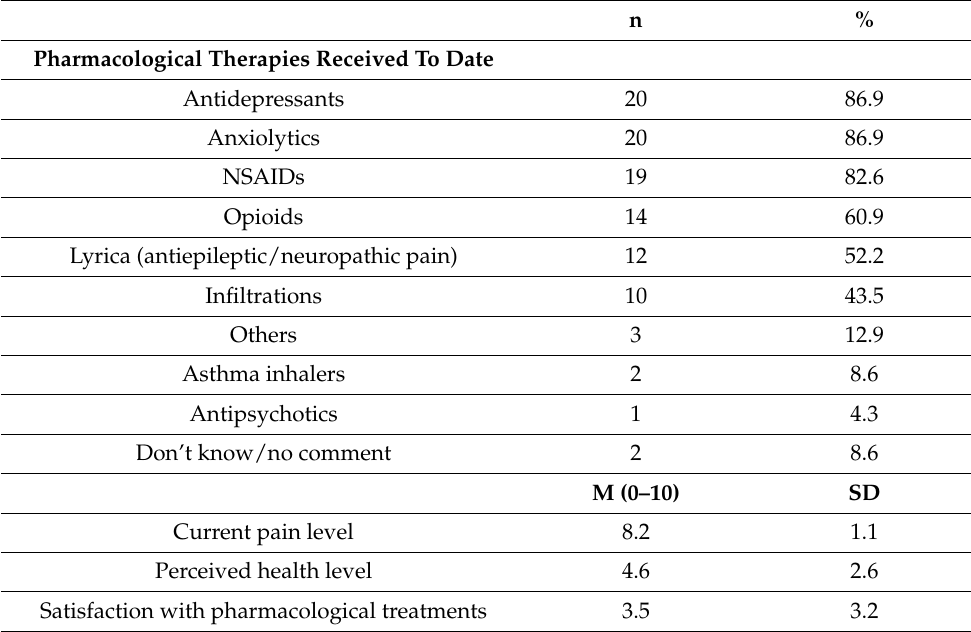
Table 3. Pharmacological